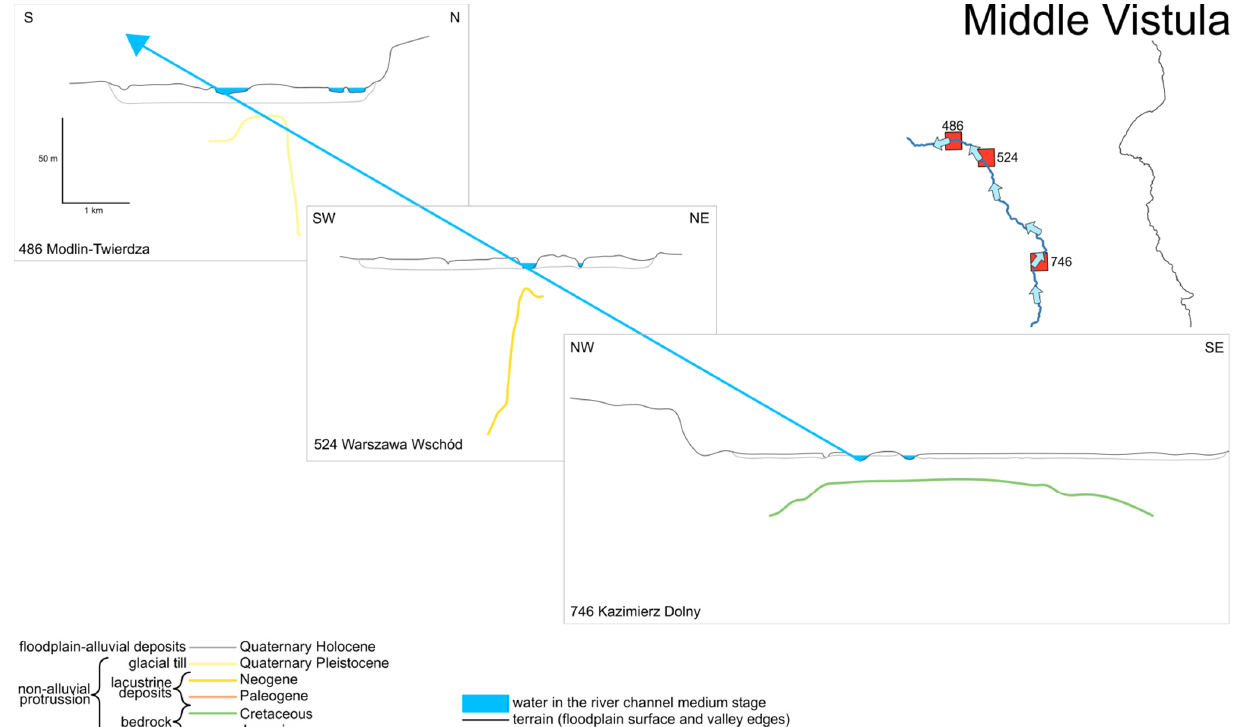
Figure 7. Geological cross-sections through the Middle Vistula River valley, according to [67–69]. Each cross-section presents: water in the river channel during medium stage (blue body); schematic river channel with flow direction (blue line) the valley profile graph with the floodplain surface and the valley’s walls (black), alluvial cover of the floodplain (grey) and non-alluvial protrusion underneath. The color of the non-alluvial protrusion indicates its age according to the stratigraphic chart [43].